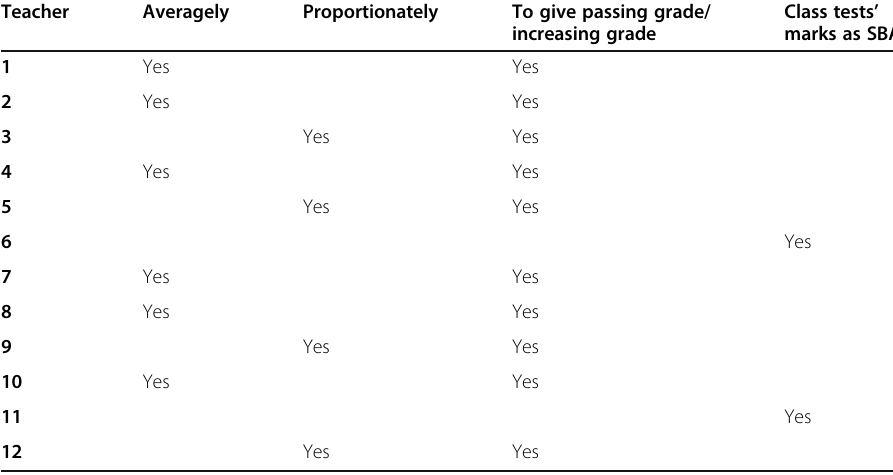
Table 4 Strategies adopted in giving marks of SBA by teachers Teacher Averagely Proportionately To give passing grade/